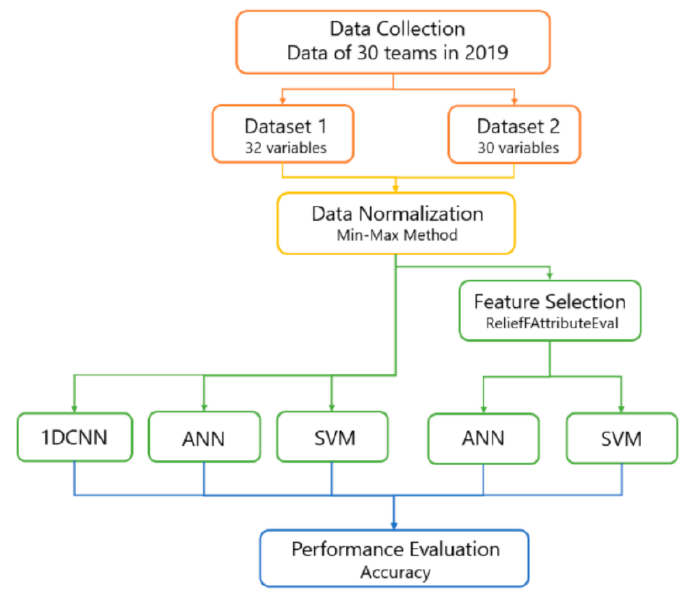
Figure 1. The research